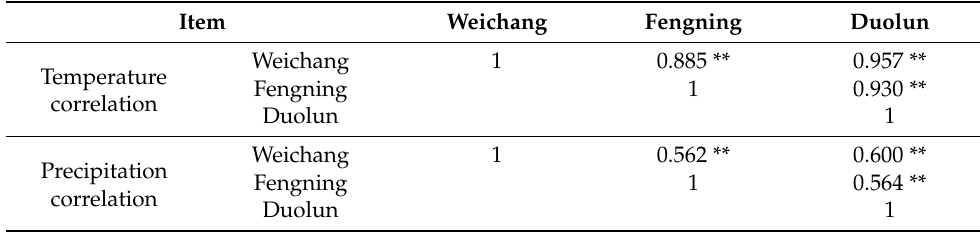
Table 1. Correlation matrix of the annual climatic factors of three stations.